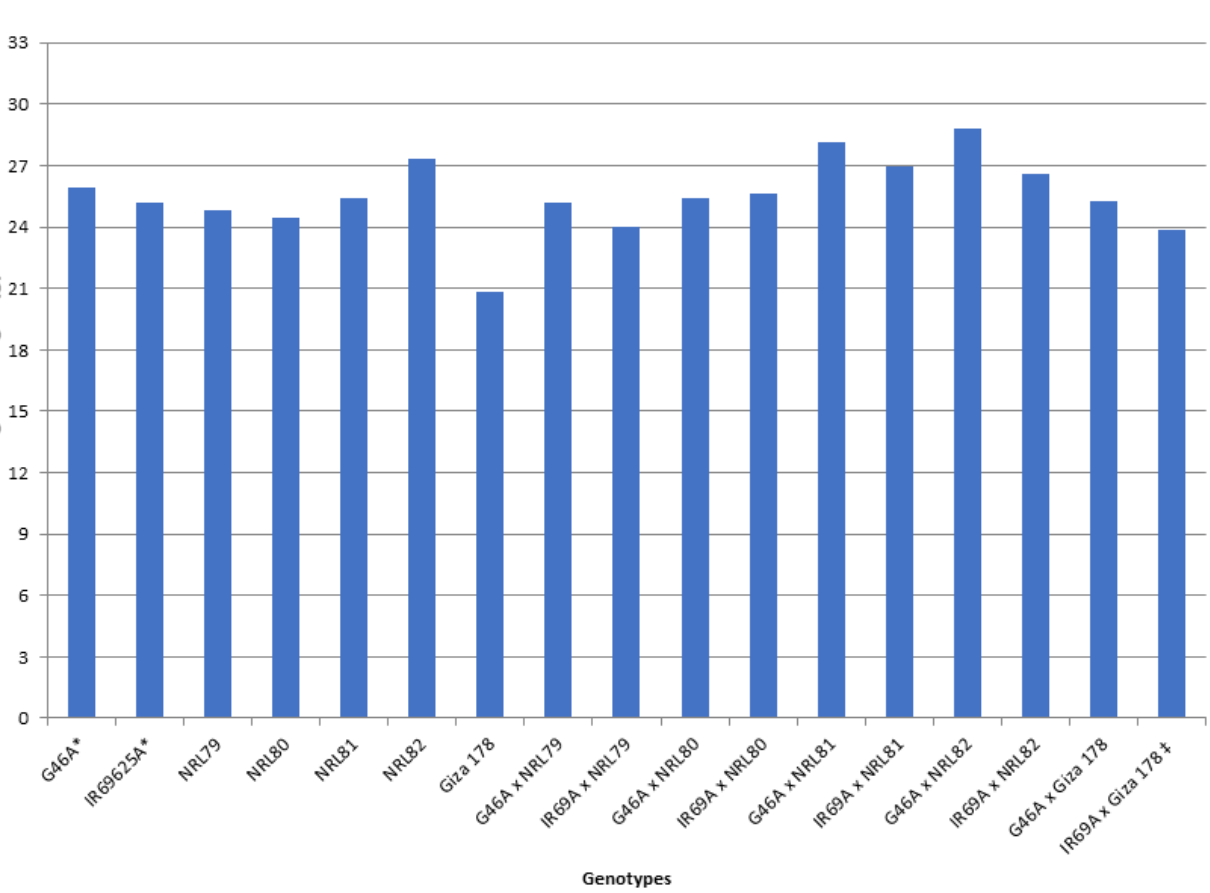
Figure 5. The mean performance for the 1000-grain weight of the studied genotypes. *: The traits were recorded on maintainer lines that were related to CMS lines, ‡: Hybrid check.